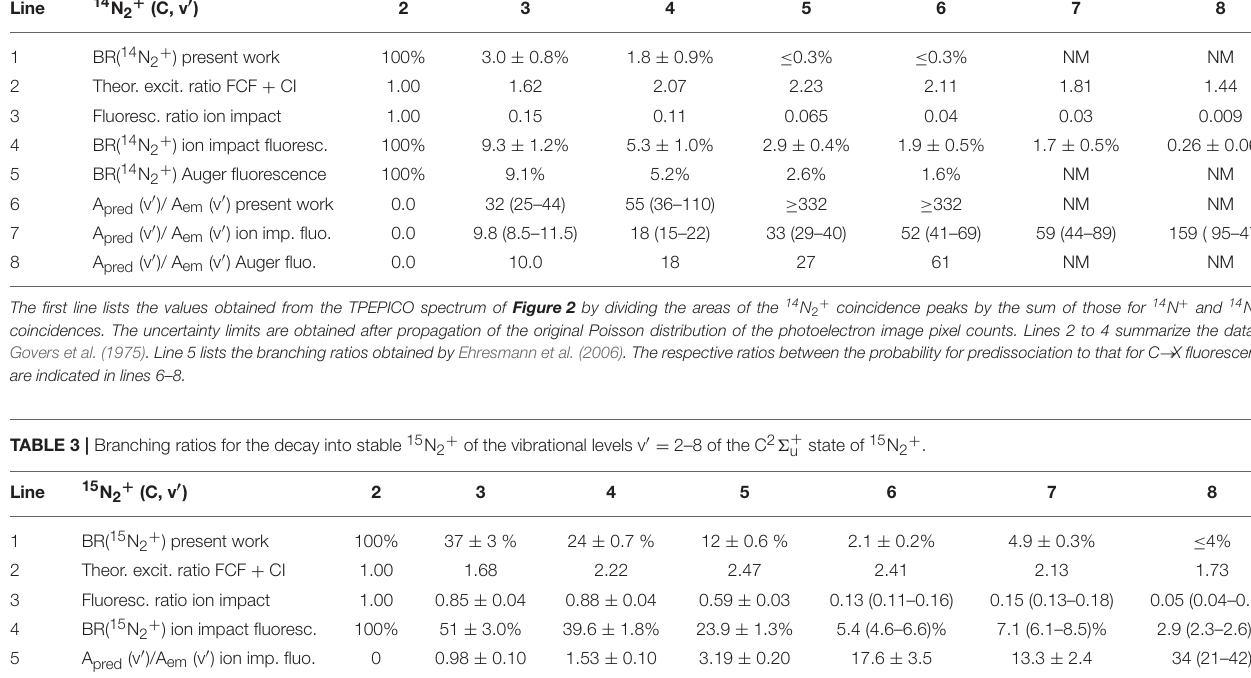
TABLE 2 | Branching ratios for the decay into stable 14 N 2 + of the vibrational levels v ′ Line